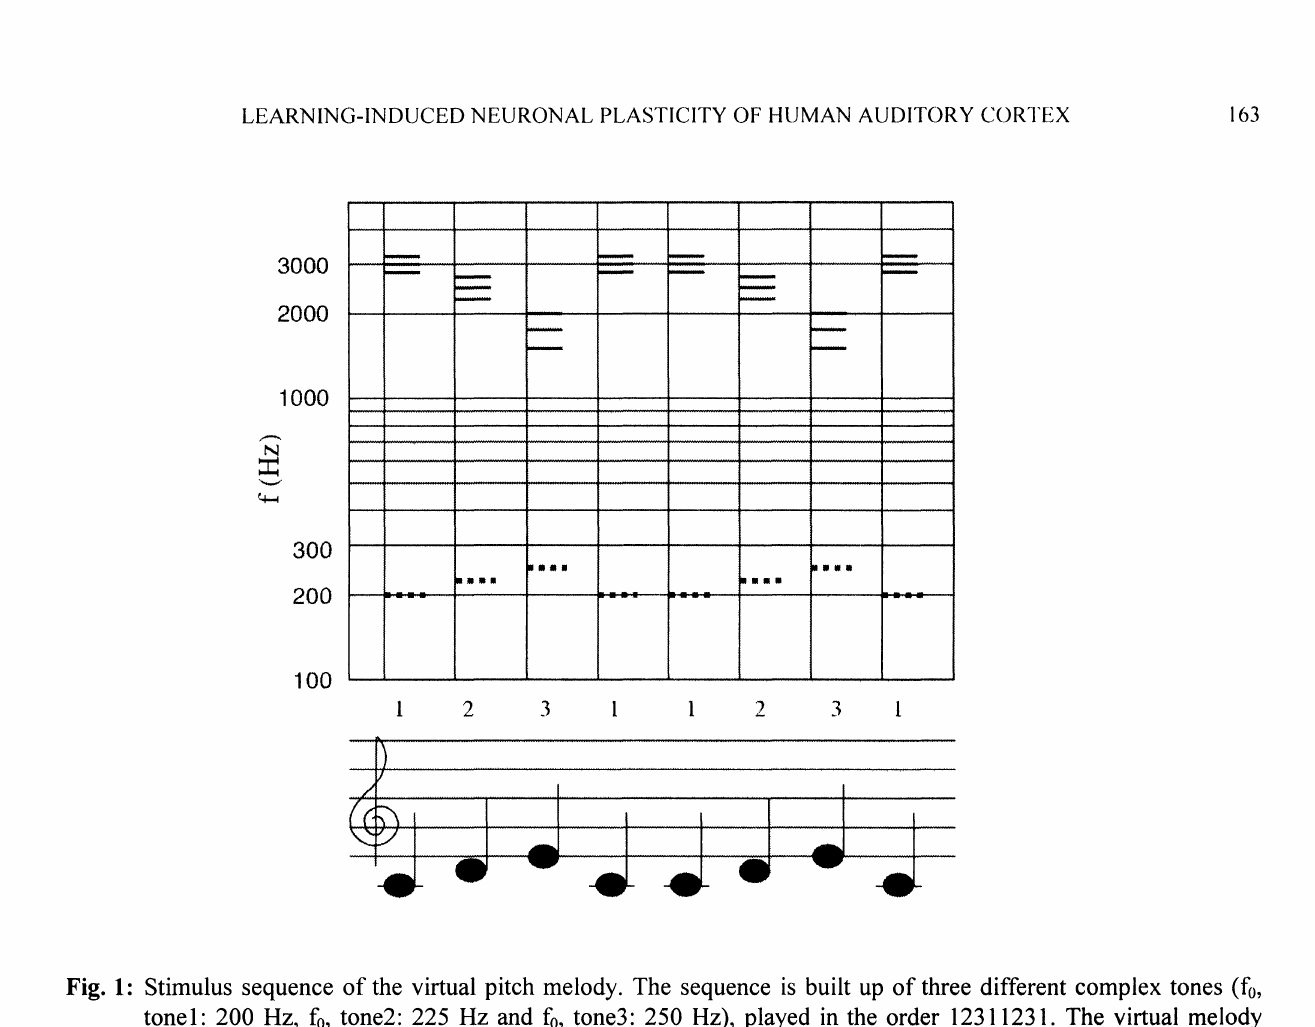
The complex tones were composed by three harmonics of a missing fundamental frequency (f0), which was set to 200, 225, and 250 Hz,